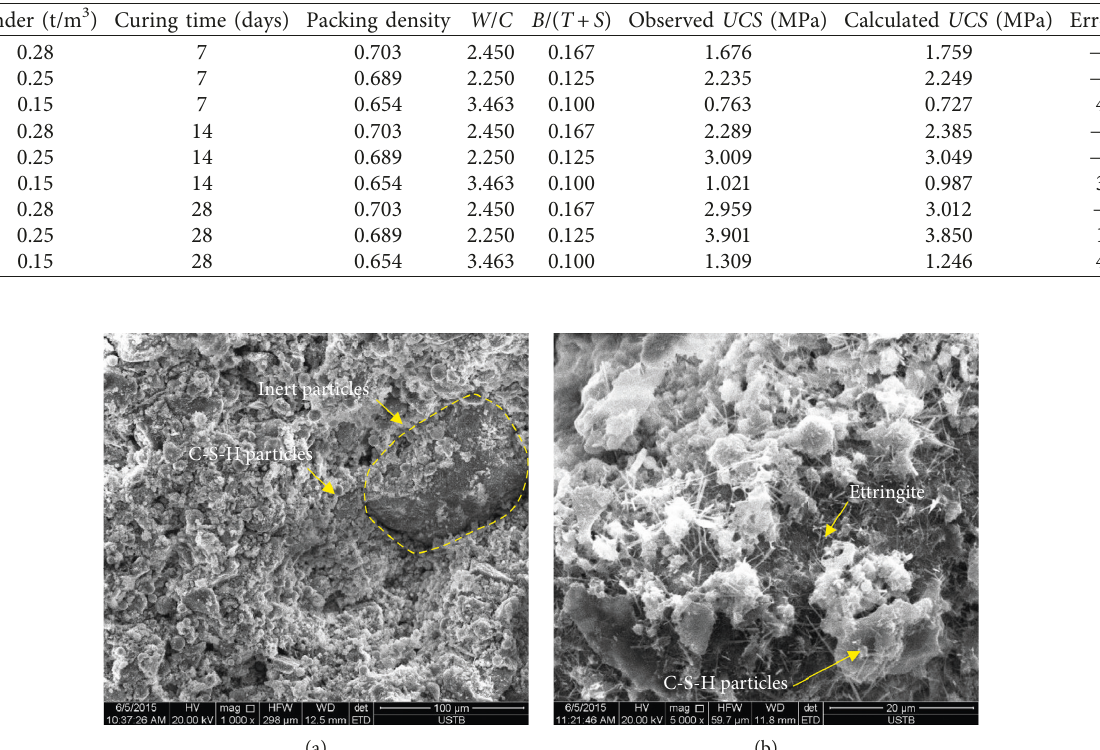
Table 4: Proportions of materials and strength results.